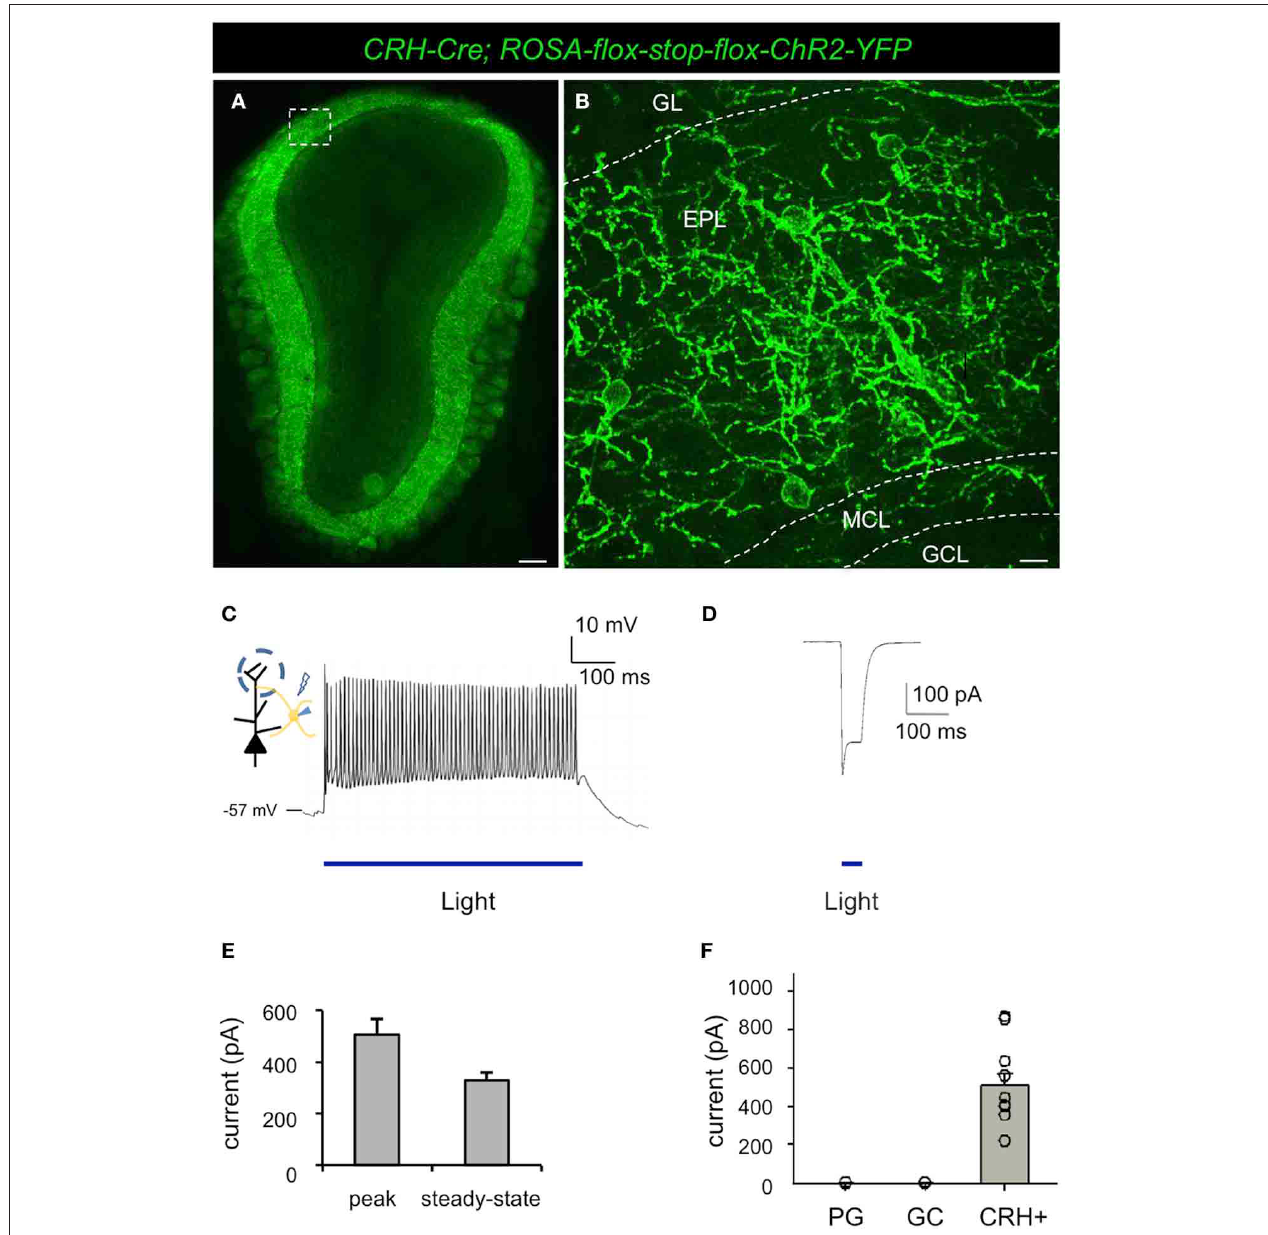
FIGURE 5 | Conditional expression of ChR2 under the control of CRH-Cre allows optogenetic manipulation of a subset of EPL interneurons. (A) Epifluorescence microscope image showing conditional ChR2 expression in a subset of EPL interneurons in CRH-Cre; ROSA-lox-stop-lox-ChR2 mice. (B) Confocal image showing a higher magnification view of inset shown in (A) highlighting ChR2 localization to the membrane and dendritic processes of EPL interneurons. GL, glomerular layer; EPL, external plexiform layer; MCL, mitral cell layer; GCL, granule cell layer. Scale bars: left, 300 μ m; right,